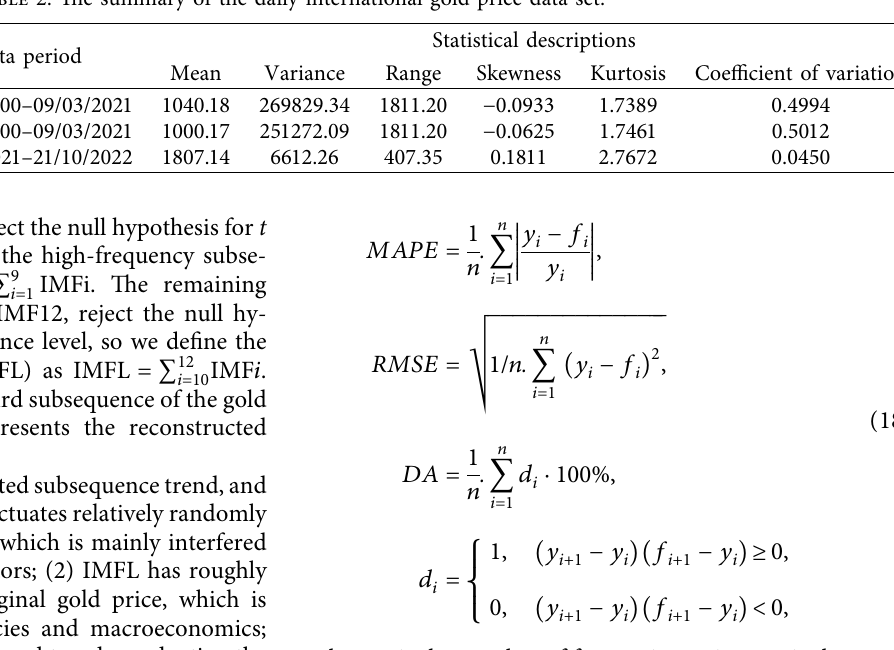
Figure 3: Daily international gold price curve (January 3, 2000–October 21, 2022). Table 2: Te summary of the daily international gold price data